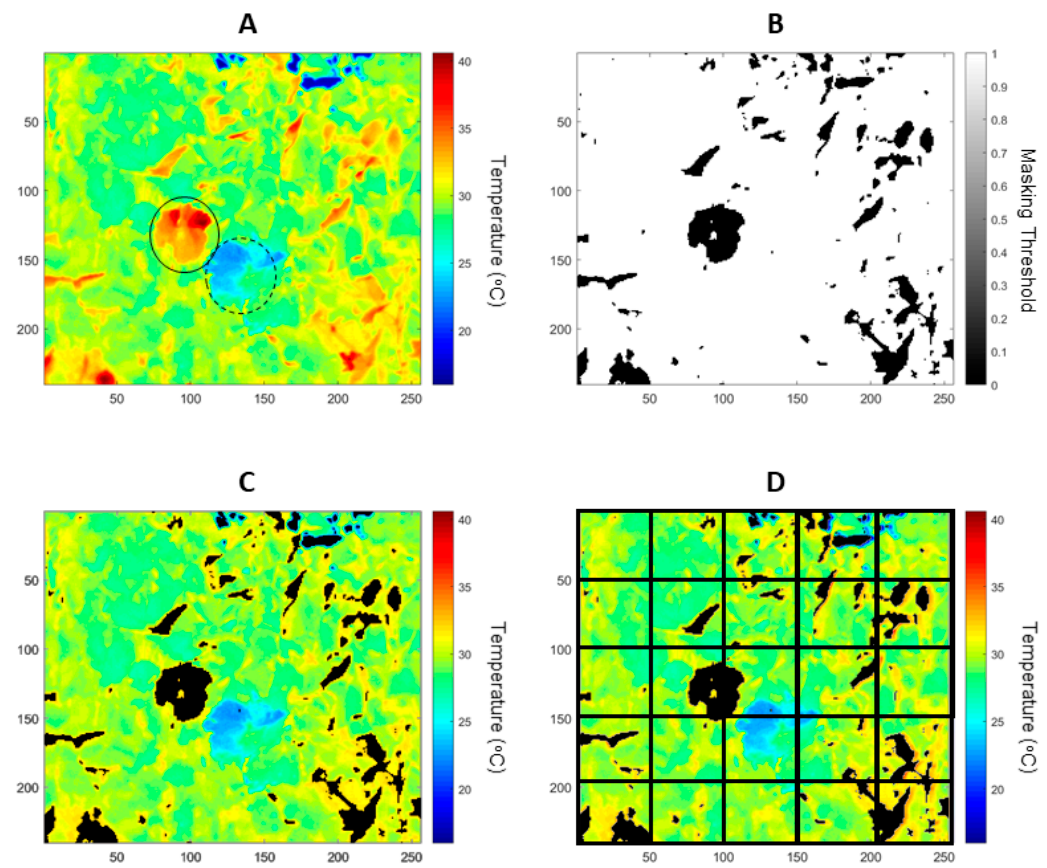
Figure 2. Examples of a radiometric thermal image ( A ) processing for data extraction of T dry (A, solid circle) and T wet (A, dotted circle) by painting leaves with petroleum jelly and water, respectively. Binary image obtained by thresholding T dry and T wet ( B ); masked radiometric image extracting non-leaf material, such as overheated elements and sky ( C ); and subdivision of thermal image to extract information from sections of the canopy in a 5 × 5 sub-division ( D ).